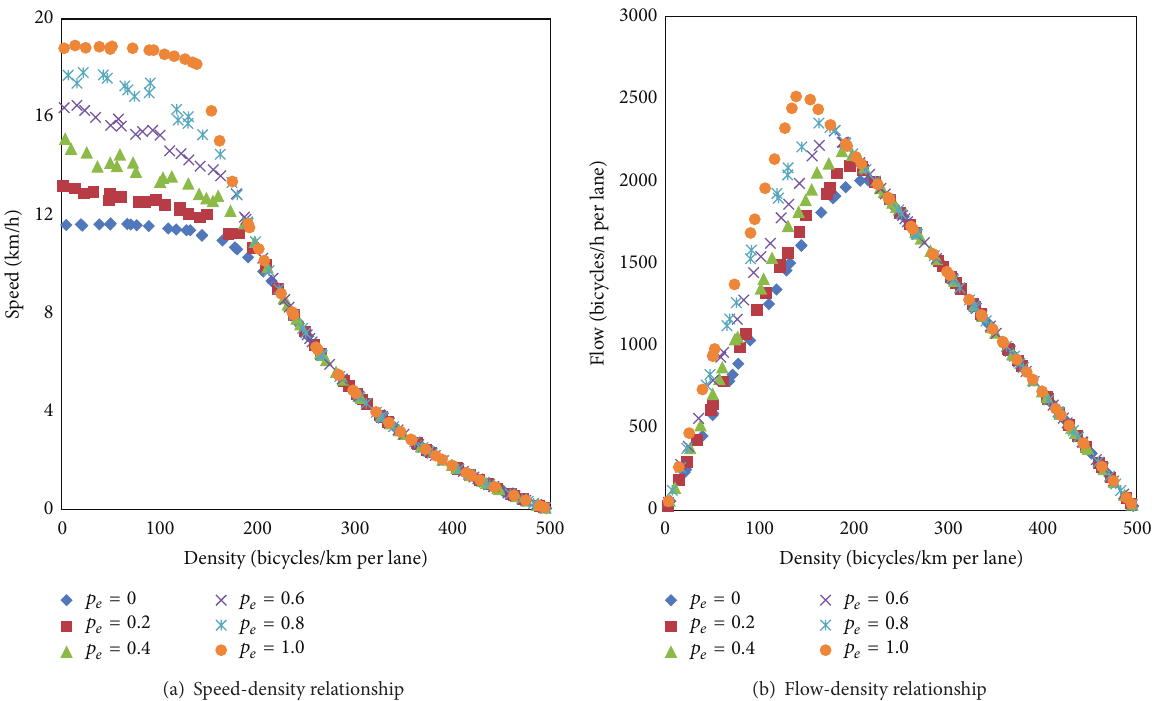
Figure 5: Speed-density and flow-density relationships under different proportions of EBs when 𝑝 𝑑 =